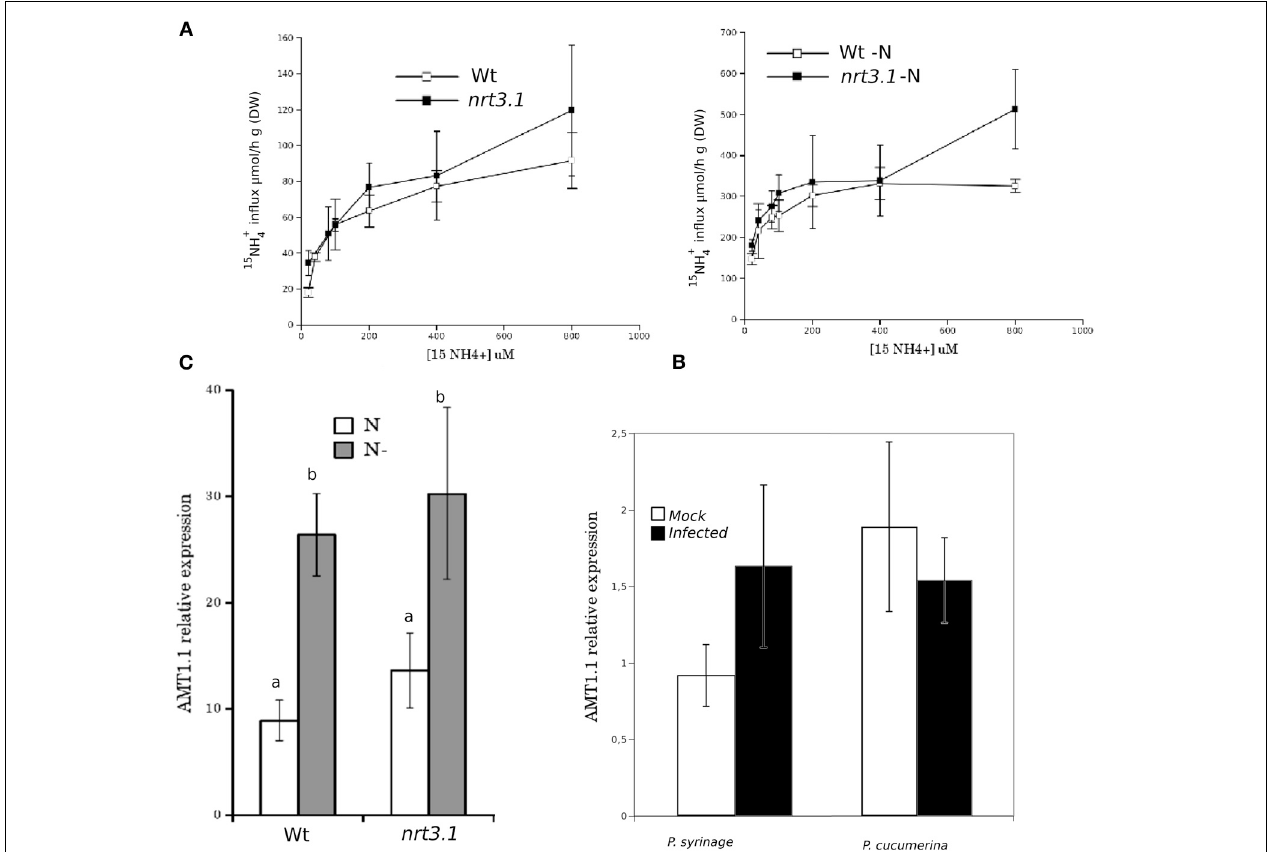
FIGURE 2 | (A) Kinetics of 15 NH + 4 influx in Col-0 and nrt3.1 roots in the low 15 NH + 4 concentration range. Plants were grown hydroponically with N supplied as 1mM NH 4 NO 3 during 6 weeks. After that one group of plants were transferred to 1mM NH 4 NO 3 , other group of plants were transferred to N-free nutrient solution (-N) during 48h. 15 NH + 4 influx was measured at different concentrations of external 15 NH + 4 . Each data is the mean of 30 replicates ± SE. (B) Real-time PCR analysis of the expression of AMT1.1 in Col-0 and nrt3.1 plants fertilized normally along 5 weeks and exposed to N starvation 2 days (-N). The AMT1.1 transcript levels were normalized to the